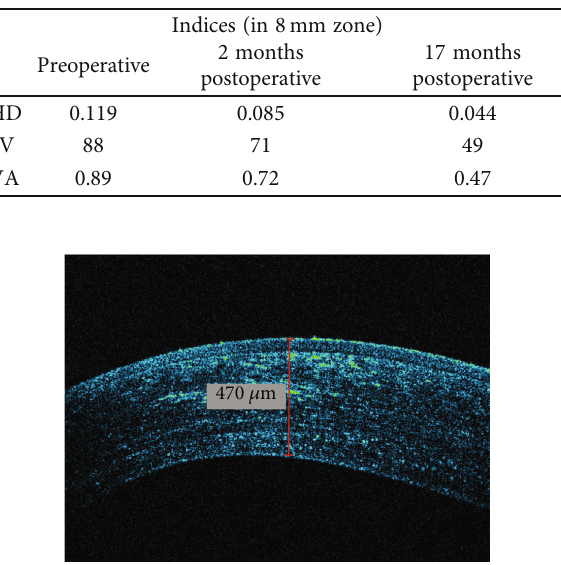
Table 2: Preoperative and postoperative values of corneal indices in 8mm zone of the left eye.